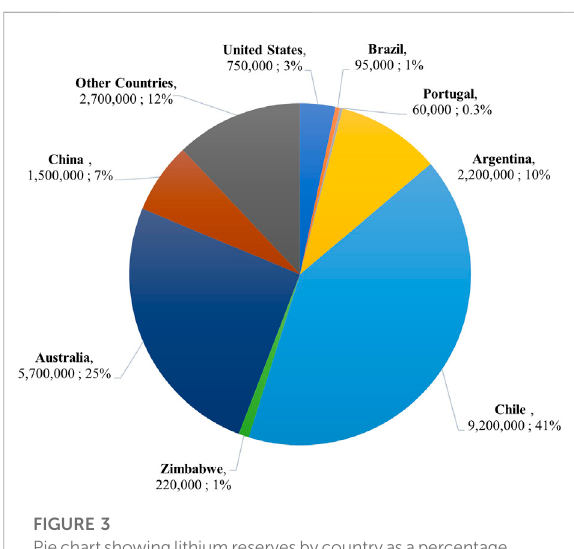
FIGURE 3 Piechartshowinglithiumreservesbycountryasapercentage of the total world-wide reserves in 2021 (U.S Geological Survey,